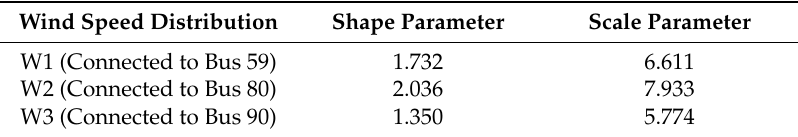
Table 7. The correlation matrix (modified IEEE 118-bus test system).